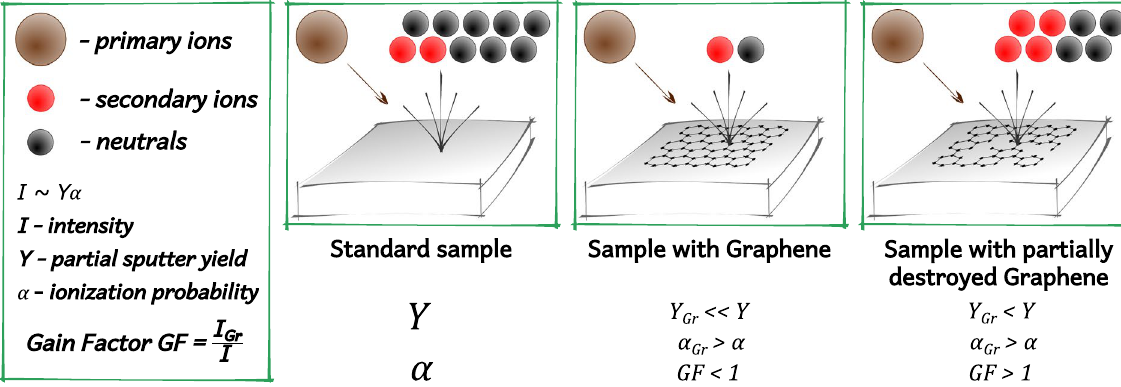
Figure 1. The basic concept of GESIMS analysis. Graphene blocks the emission of the matter from the substrate but significantly increases the ionization probability. By creating some defects in graphene layer the emission increases while the ionization ability is preserved and thus more ions can reach the detector, resulting in enhanced SIMS signal.